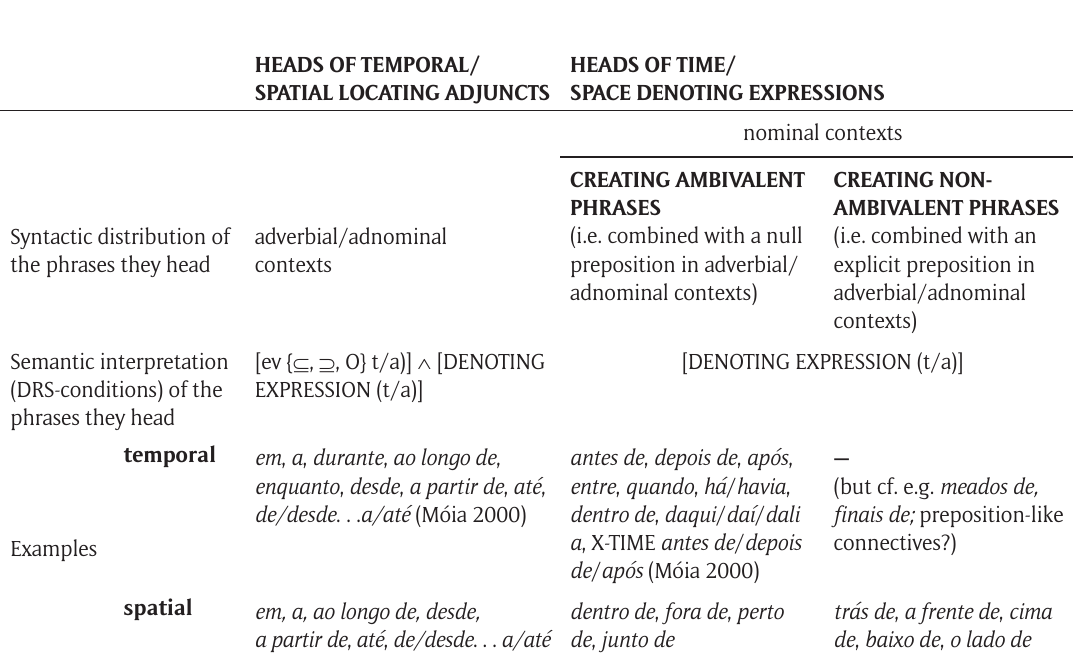
Table 1: Partition of temporal/spatial prepositions and similar